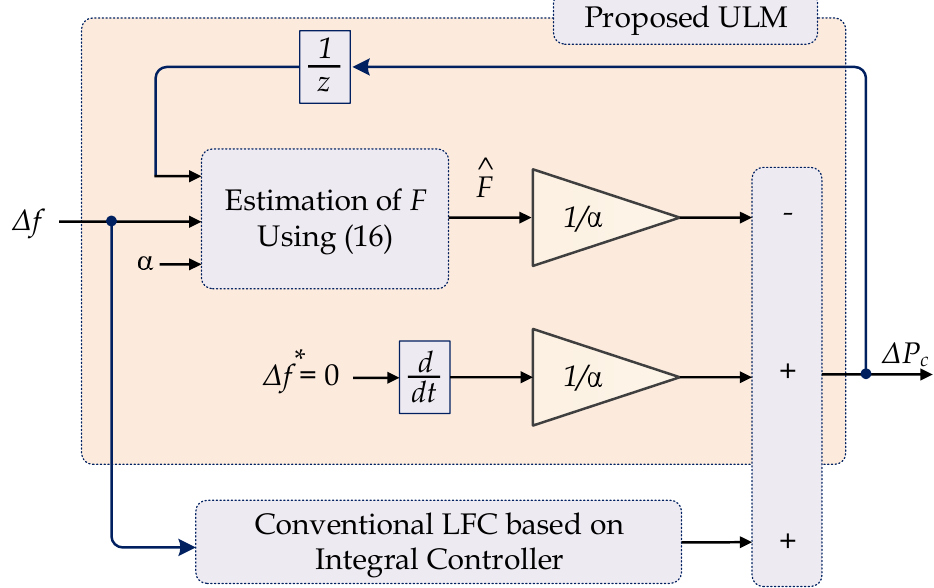
Figure 4. Structure of the proposed optimal ULM incorporated with the integral controller for LFC of µ